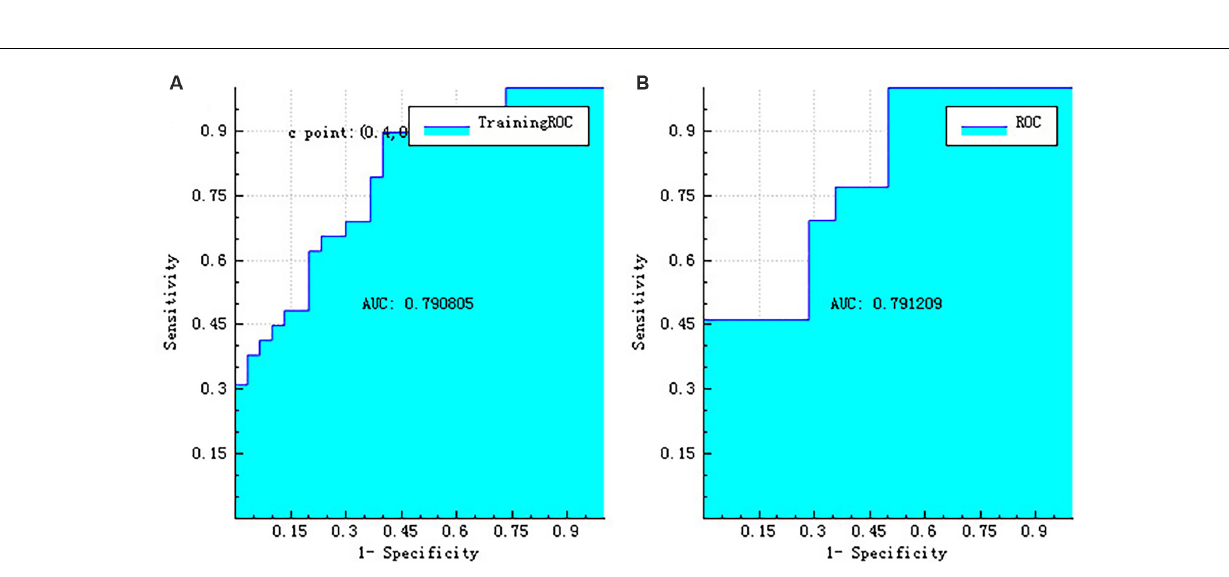
FIGURE 7 | The radiomics score based on testing data of the right hippocampus. Red represents the normal group, and blue represents the patient group. The red area below the horizontal line and the blue area above the horizontal line represent the right prediction. On the contrary, the red area above the horizontal line and the blue area below the horizontal line represent the false prediction.